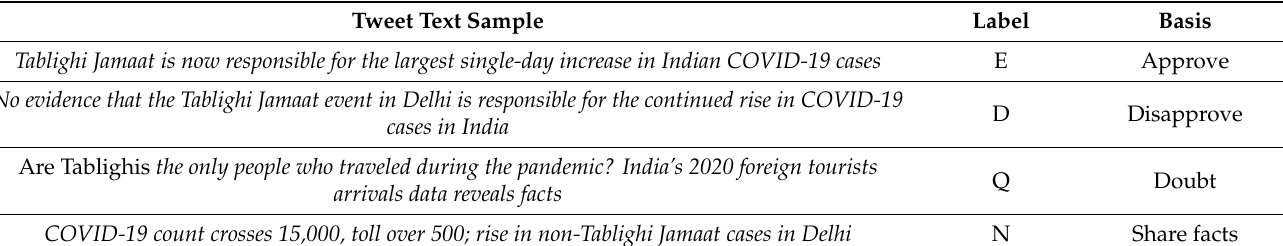
Table 1. Example of tweets under four categories of